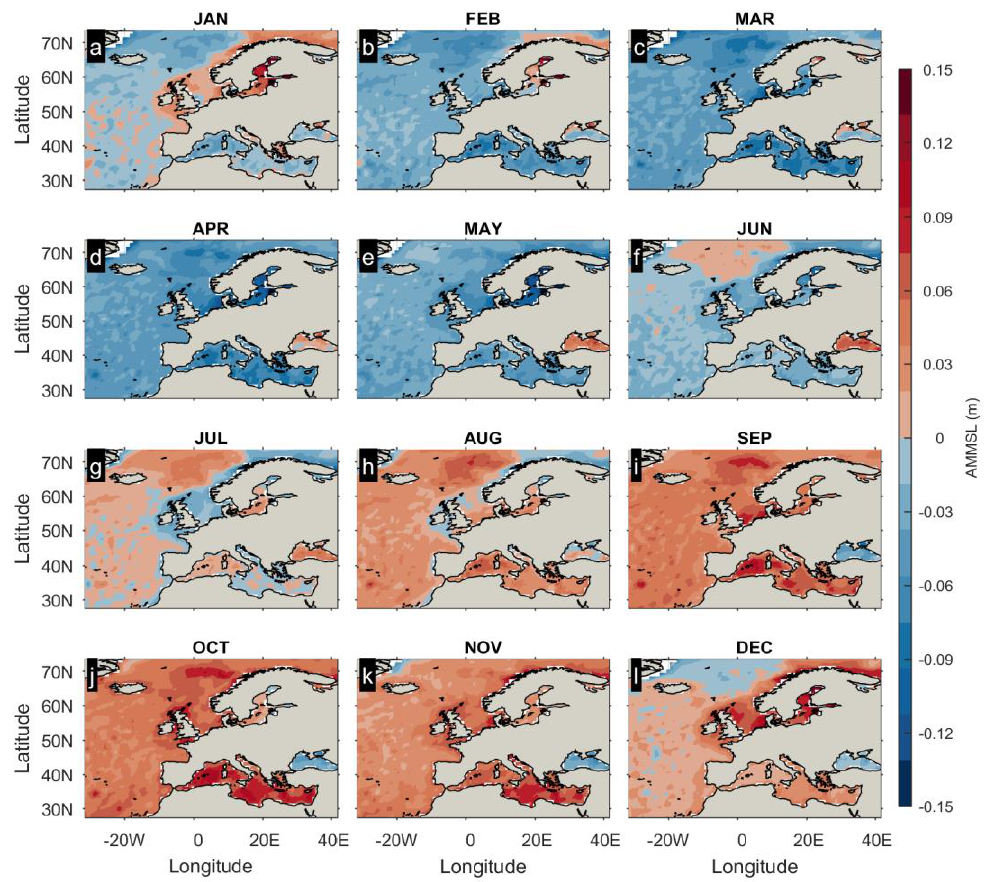
Figure 2. Seasonality of the annual cycle (( a – l ) January–December) of the average monthly mean sea level (AMMSL) in the study area from 1993 to 2016. Warm / cold colour indicates positive / negative values.